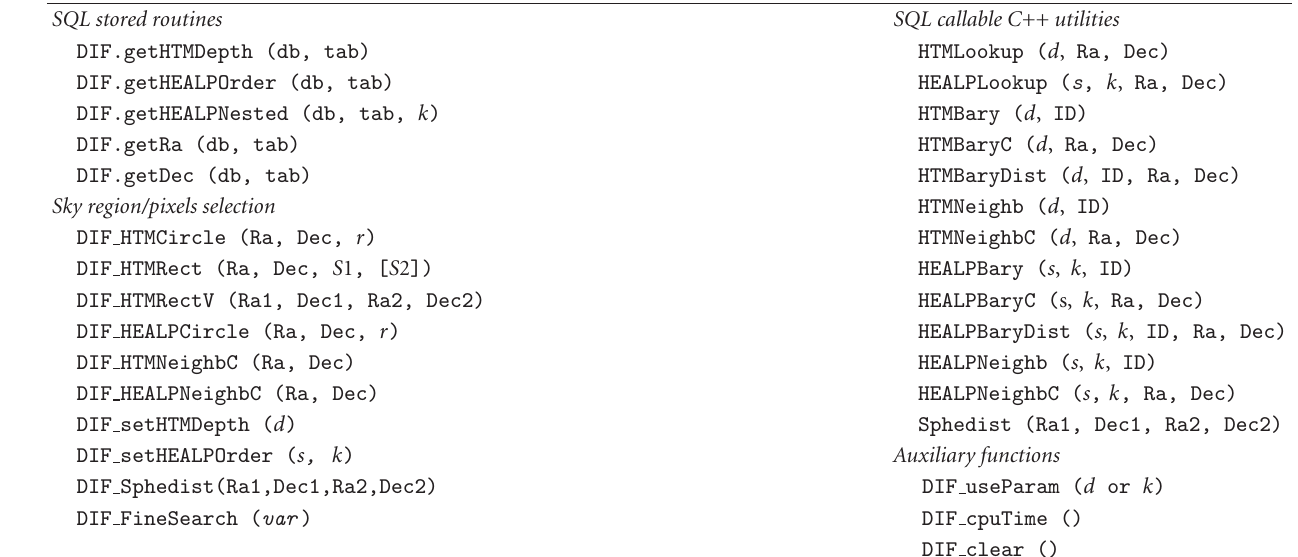
Table 2: DIF functions available in